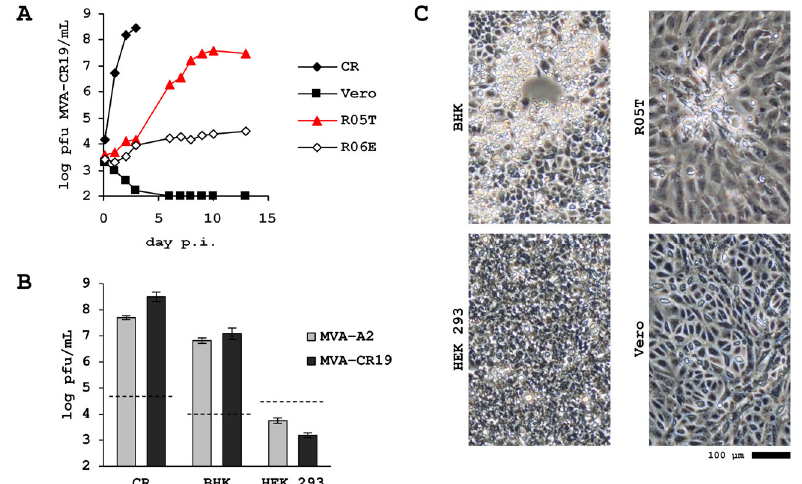
Figure 6. Host cell-restriction of MVA-CR isolate MVA-CR19. Cells were seeded with 5 × 10 5 (CR), 2 × 10 5 (R05T and HEK 293), and 1 × 10 5 (R06E and Vero), respectively, per well of a 6-well plate and MVA was added to an MOI of 0.1. Cell lysate was prepared by freezing the plates and sonicating a thawed lysate thereof at the indicated time